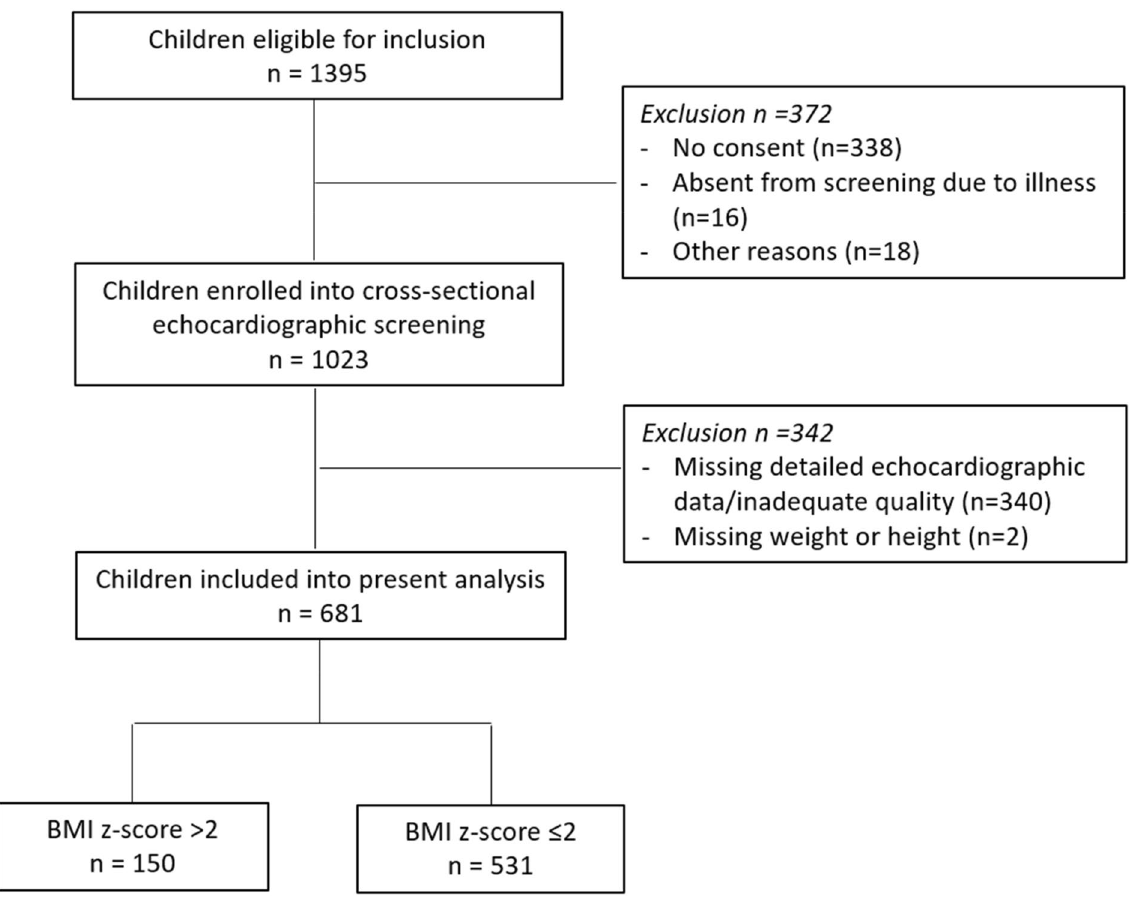
Figure 1. Study flow chart. The study flow chart illustrates the number of eligible children and the number of children included for the purpose of the present analysis. All patients (n = 681) Non-obese (BMIz ≤ 2) (n = 531) Obese (BMIz > 2) (n = 150)